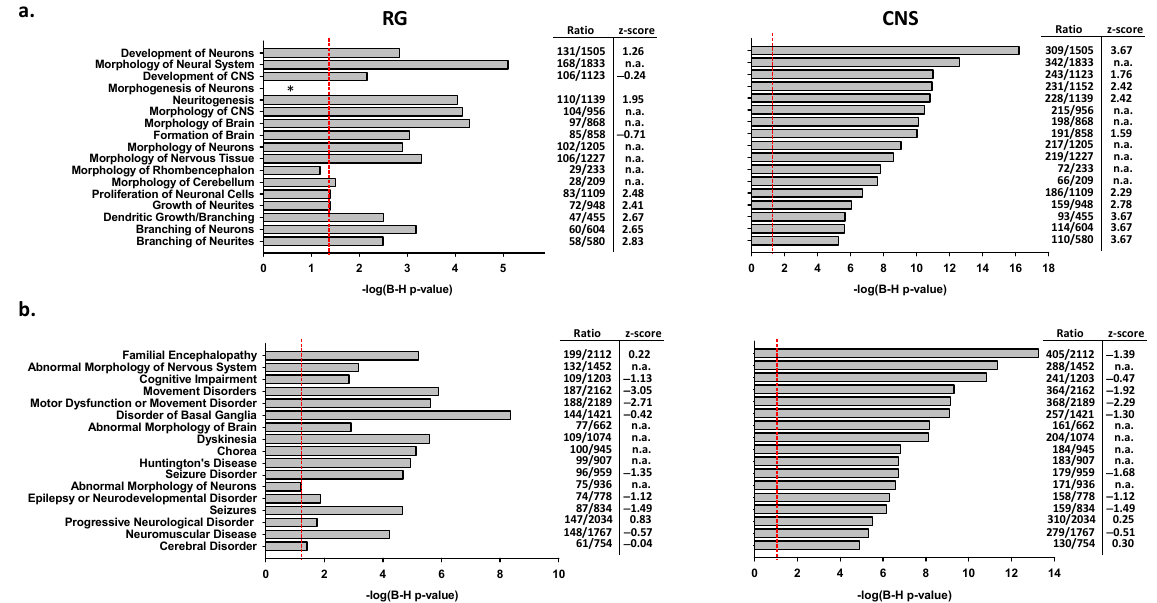
Figure 6. Targets of CNS-specific and reference PGC-1 α proteins reveal comparable and distinct associations with neuronal function and neurological diseases. Top pathways in the ingenuity function ontology category “nervous system development and function” ( a ) or the disease category “neurological diseases” ( b ) for DEGs after RG or CNS promoter activation; the red line shows an adjusted p -value of 0.05; n.a., not available; * not among the top 40 associations listed by the program.